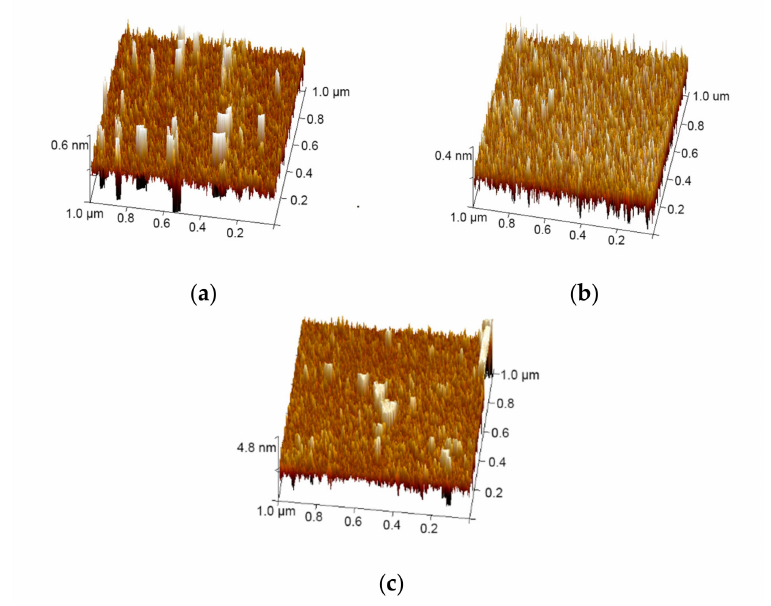
Figure 2. ( a ) AFM images (1 µ m × 1 µ m) of the bare IWO thin film. ( b ) AFM images (1 µ m × 1 µ m) of the bottom IWO on sapphire substrate. ( c ) AFM image (1 µ m × 1 µ m) of the multilayer film with a 6 nm Cu layer.